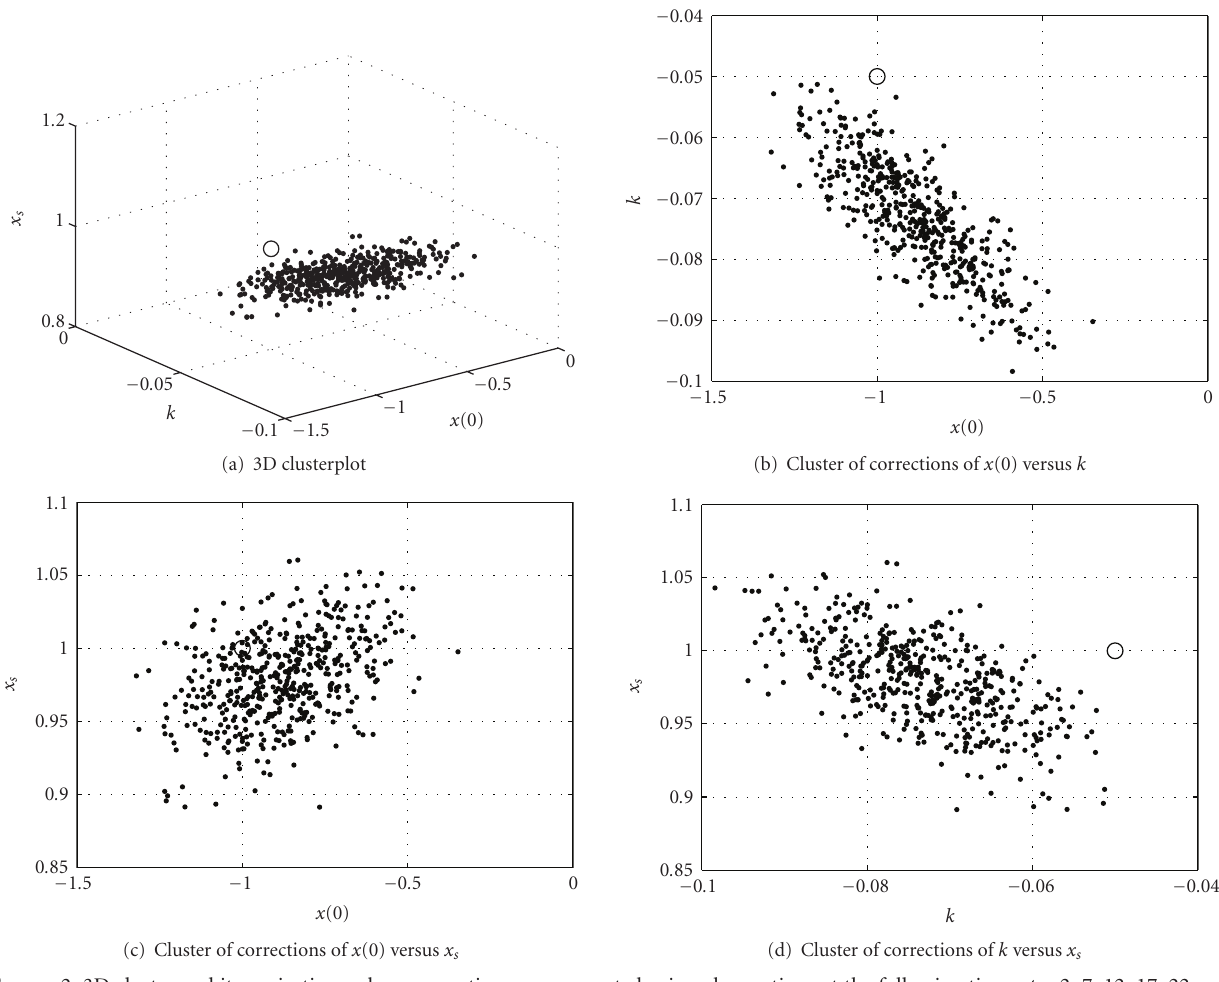
Figure 2: 3D cluster and its projections where corrections are computed using observations at the following times: t = 2, 7, 12, 17, 22, and 27. An ensemble of 100 members is used where the standard deviation of the observation noise is